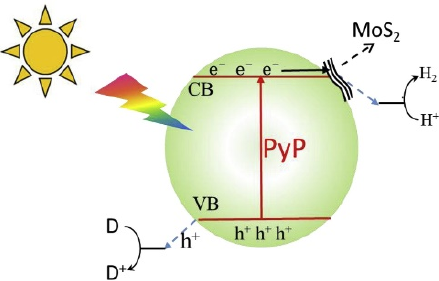
Figure 22. Schematic illustration of the between PyP and MoS 2 . D = donor [170].